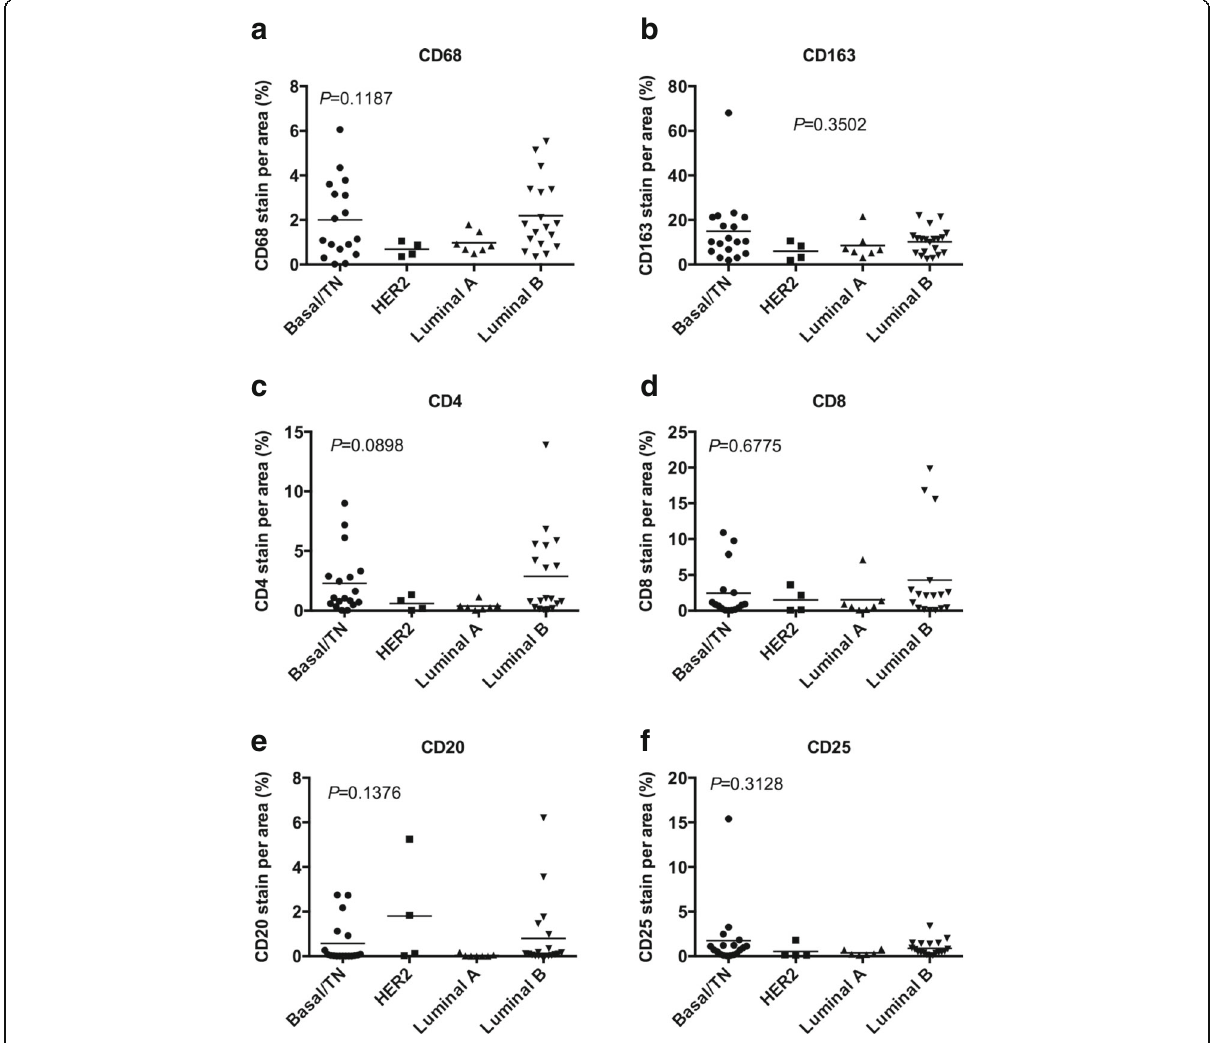
Fig. 4 The density of TILs does not differ between molecular subtypes in breast tumors from Kenya. Breast cancer tissue samples were stained for TILs, including CD68, CD163, CD4, CD8, CD20, and CD25. Each sample was scored for percentage of positively stained area for the indicated TIL. The positively stained area then was compared across molecular subtypes basal/TN, HER2, luminal A, and luminal B. The positively stained areas then were compared across molecular subtypes basal/TN, HER2, luminal A, and luminal B by Kruskal-Wallis followed by Dunn ’ s multiple comparison tests CD68 a , CD163 b , CD4 c , CD8 d , CD20 e , and CD25 f ( P =0.1187, 0.3502, 0.0898, 0.6775, 0.1376, and 0.3128, respectively). The stained areas did not significantly vary by molecular